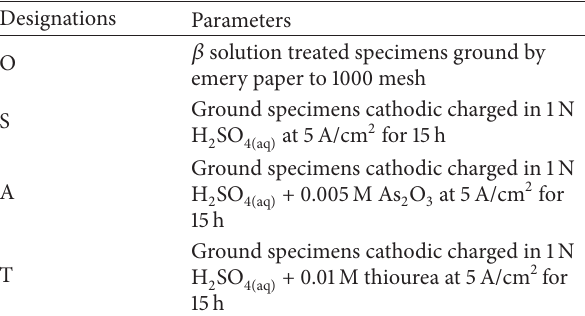
Table 3: Process designations and the associated parameters for cathode potential monitoring.